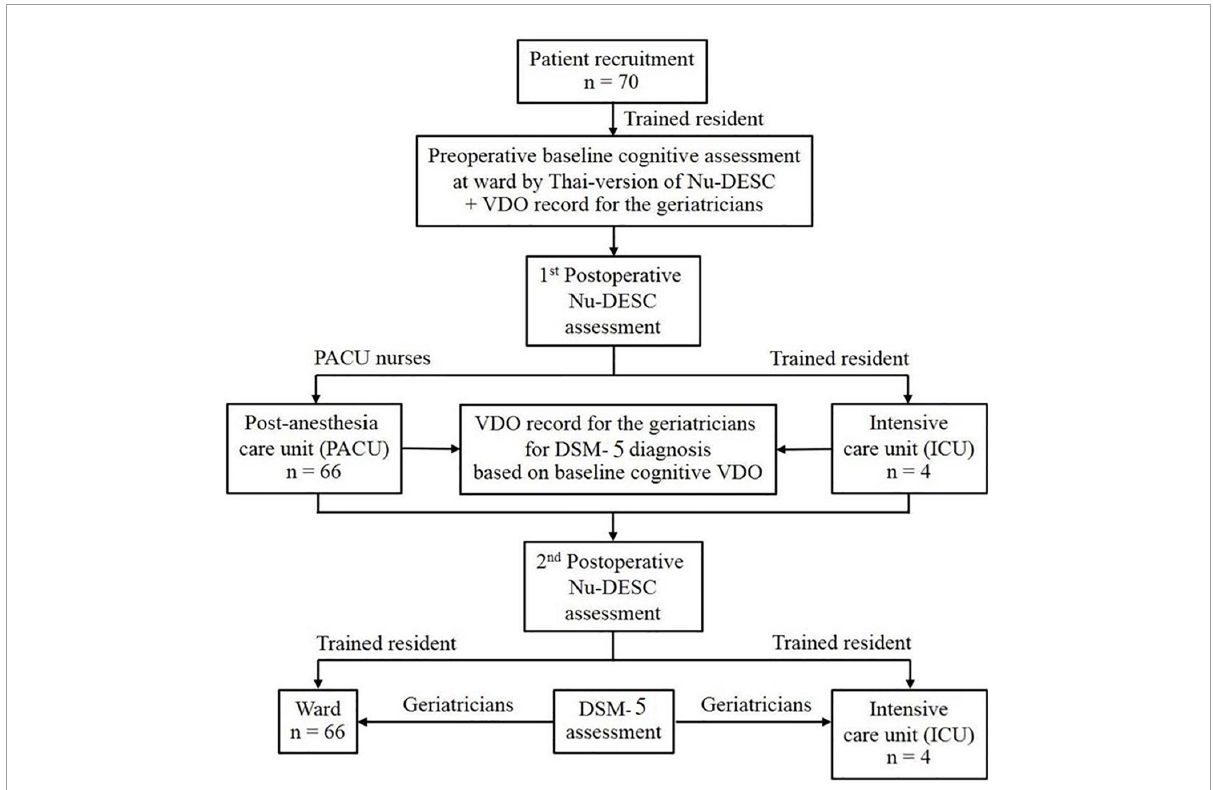
FIGURE1 Consort flow of the Nu-DESC assessments. ICU, Intensive Care Unit, Nu-DESC, Nursing Delirium Screening Scale, PACU, Post-Anesthesia Care